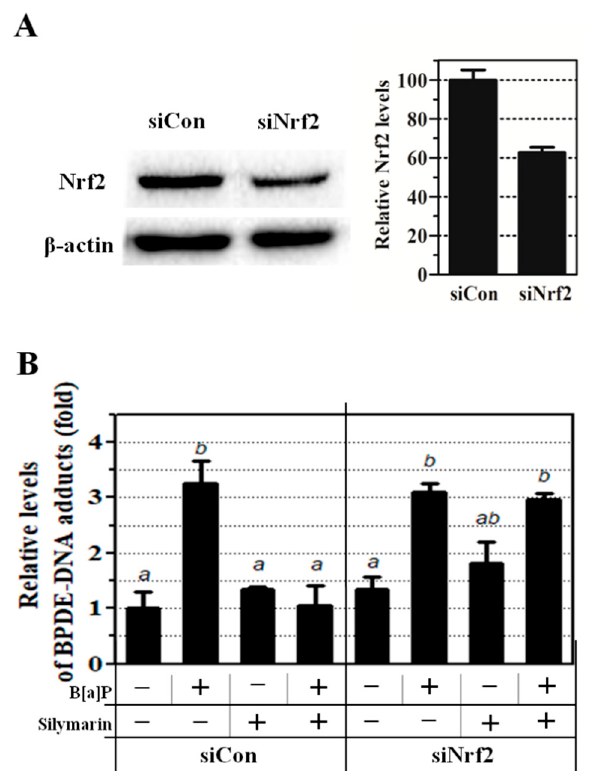
Figure 5. Knockdown of HepG2 cells was performed using Nrf2-small interfering RNA (siRNA) (siNrf2) and control siRNA (siCon). ( A ) Knockdown of cells was confirmed by Western blot. ( B ) Transfected HepG2 cells were exposed to B[a]P for 48 h. BPDE-DNA adduct formation was measured by enzyme-linked immunosorbent assay (ELISA). Each letter indicates significantly ( p < 0.05) different values (a, b, ab—mean values with the same letters for each level are not significantly different).